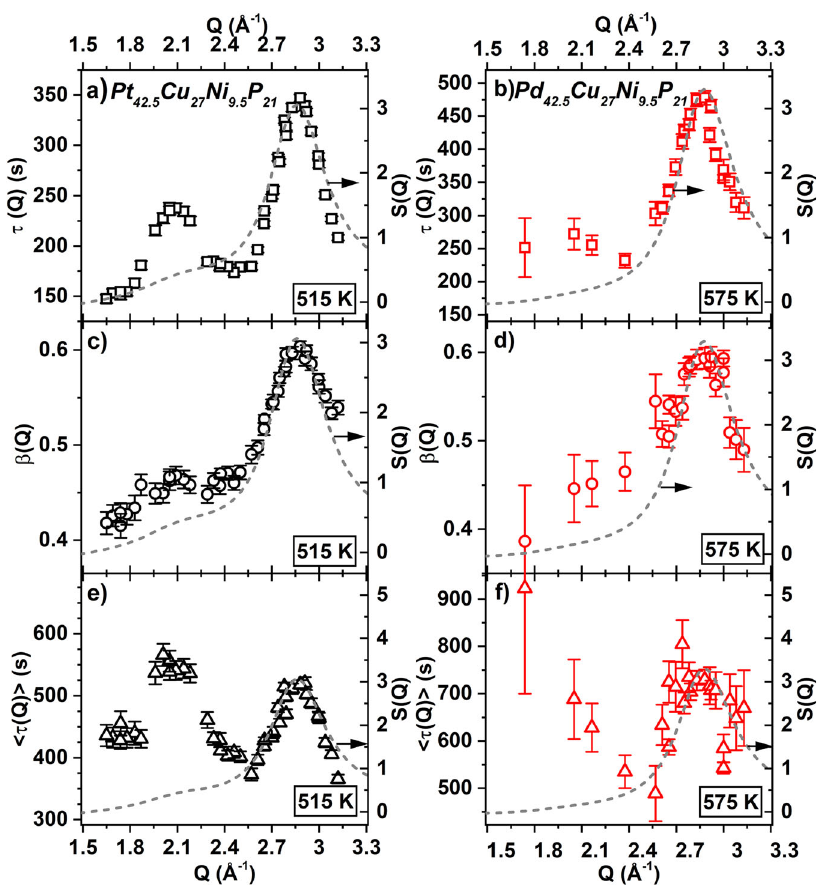
Fig. 4 Wave-vector dependence of the dynamics. Wave-vector- dependence of the Kohlrausch-Williams-Watts relaxation time ( a , b ), Kohlrausch- Williams-Watts exponent ( c , d ), and mean relaxation time ( e , f ) for the Pt-alloy at the temperature T = 515 K (left column, black) and the Pd-alloy at the temperature T = 575 K (right column, red). In all panels, the dashed grey lines represent the total structure factor S(Q) measured with synchrotron XRD. Error bars indicate the standard error due to fi tting of the experimental data using the Levenberg Marquardt